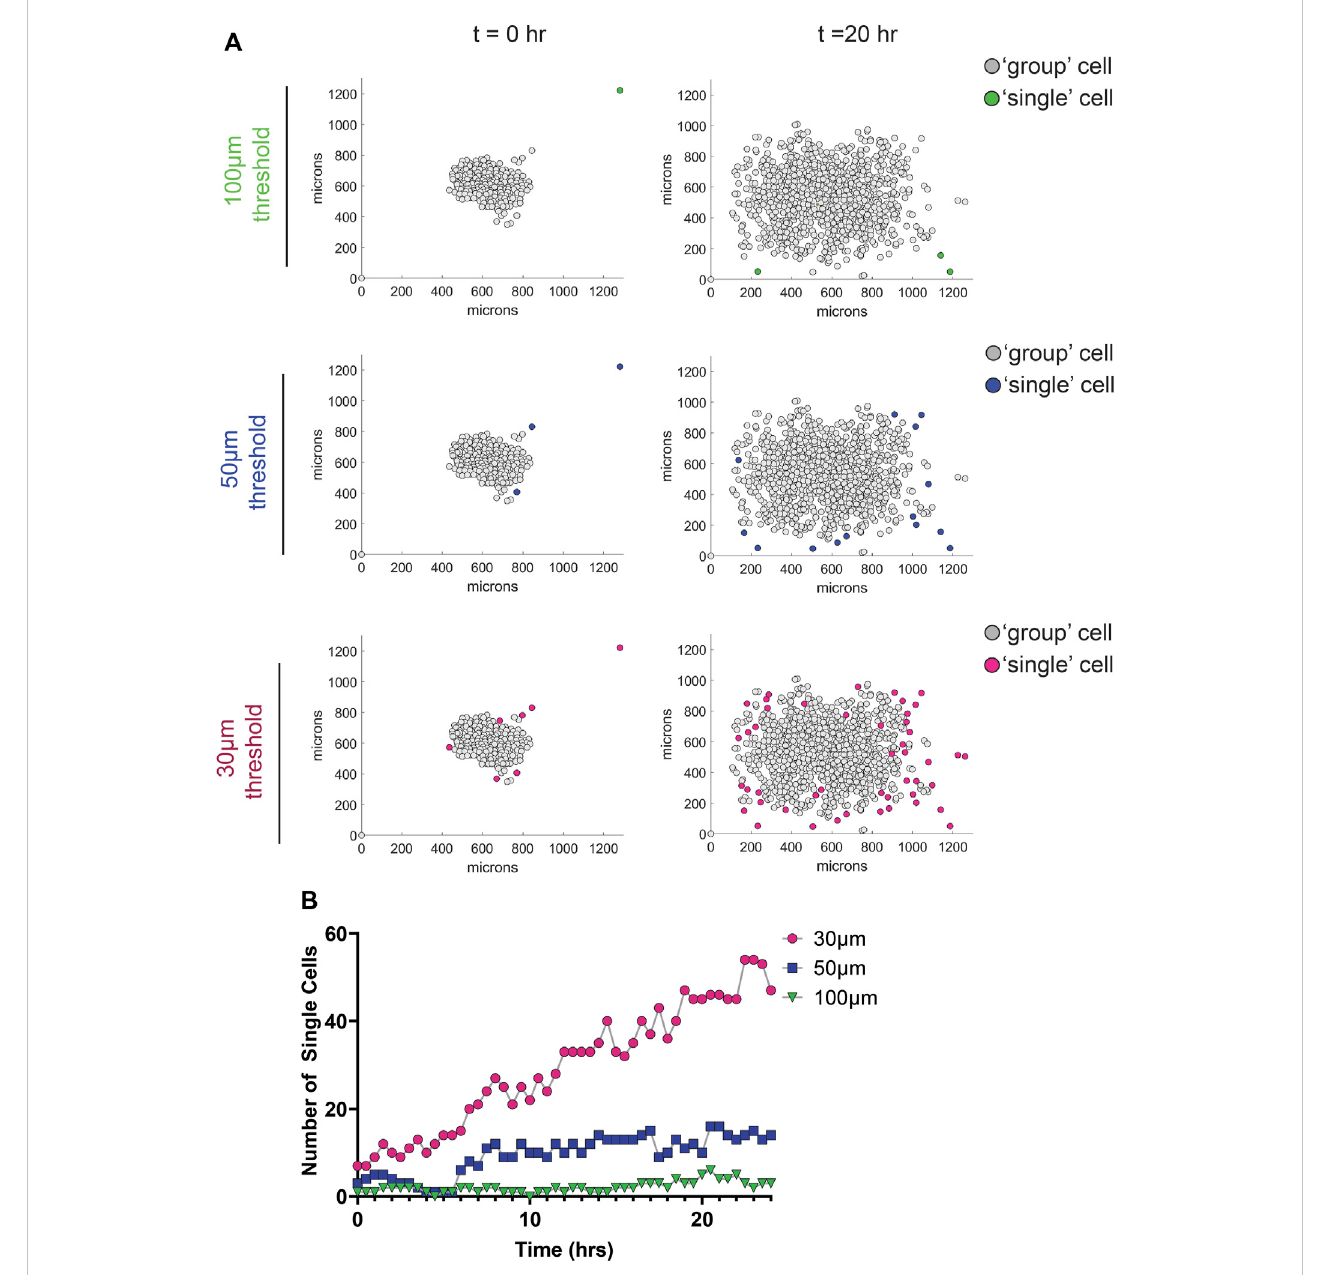
FIGURE 4 Effect of different nearest neighbor thresholds on single cell dispersion metrics of MDA-MB-231 spheroids migrating on glass. (A) Graphs depicting the location of cells 0 and 20 h after the initiation of migration using different nearest neighbor thresholds. Group cells are displayed in grey and single cells are displayed in color. (B) Graph depicting the number of single cells as a function of time for the different threshold